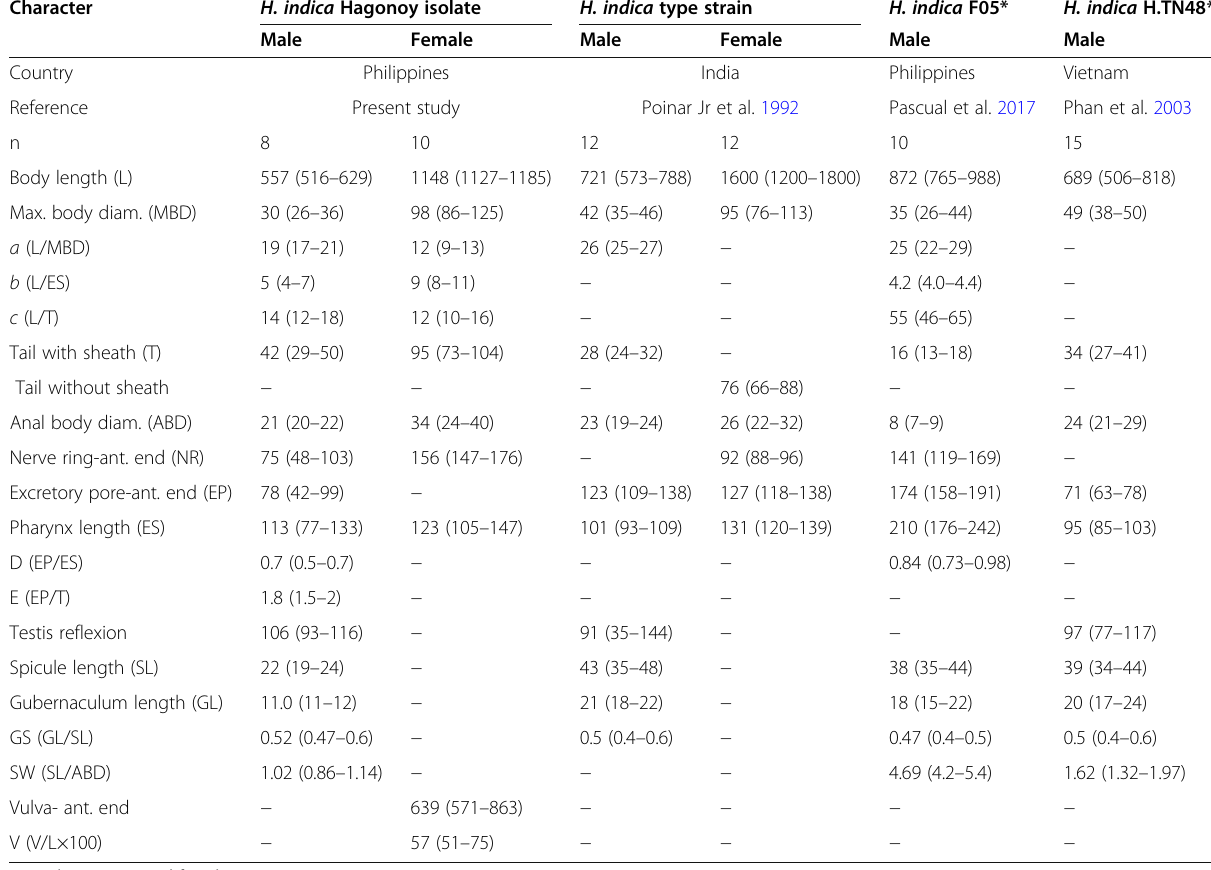
Table 3 Compendium of males and females of Heterorhabditis indica Hagonoy isolate (HBP1) with the type strain and other populations. All morphometric measurements are in micrometres (except n , ratio and percentage) and expressed as means